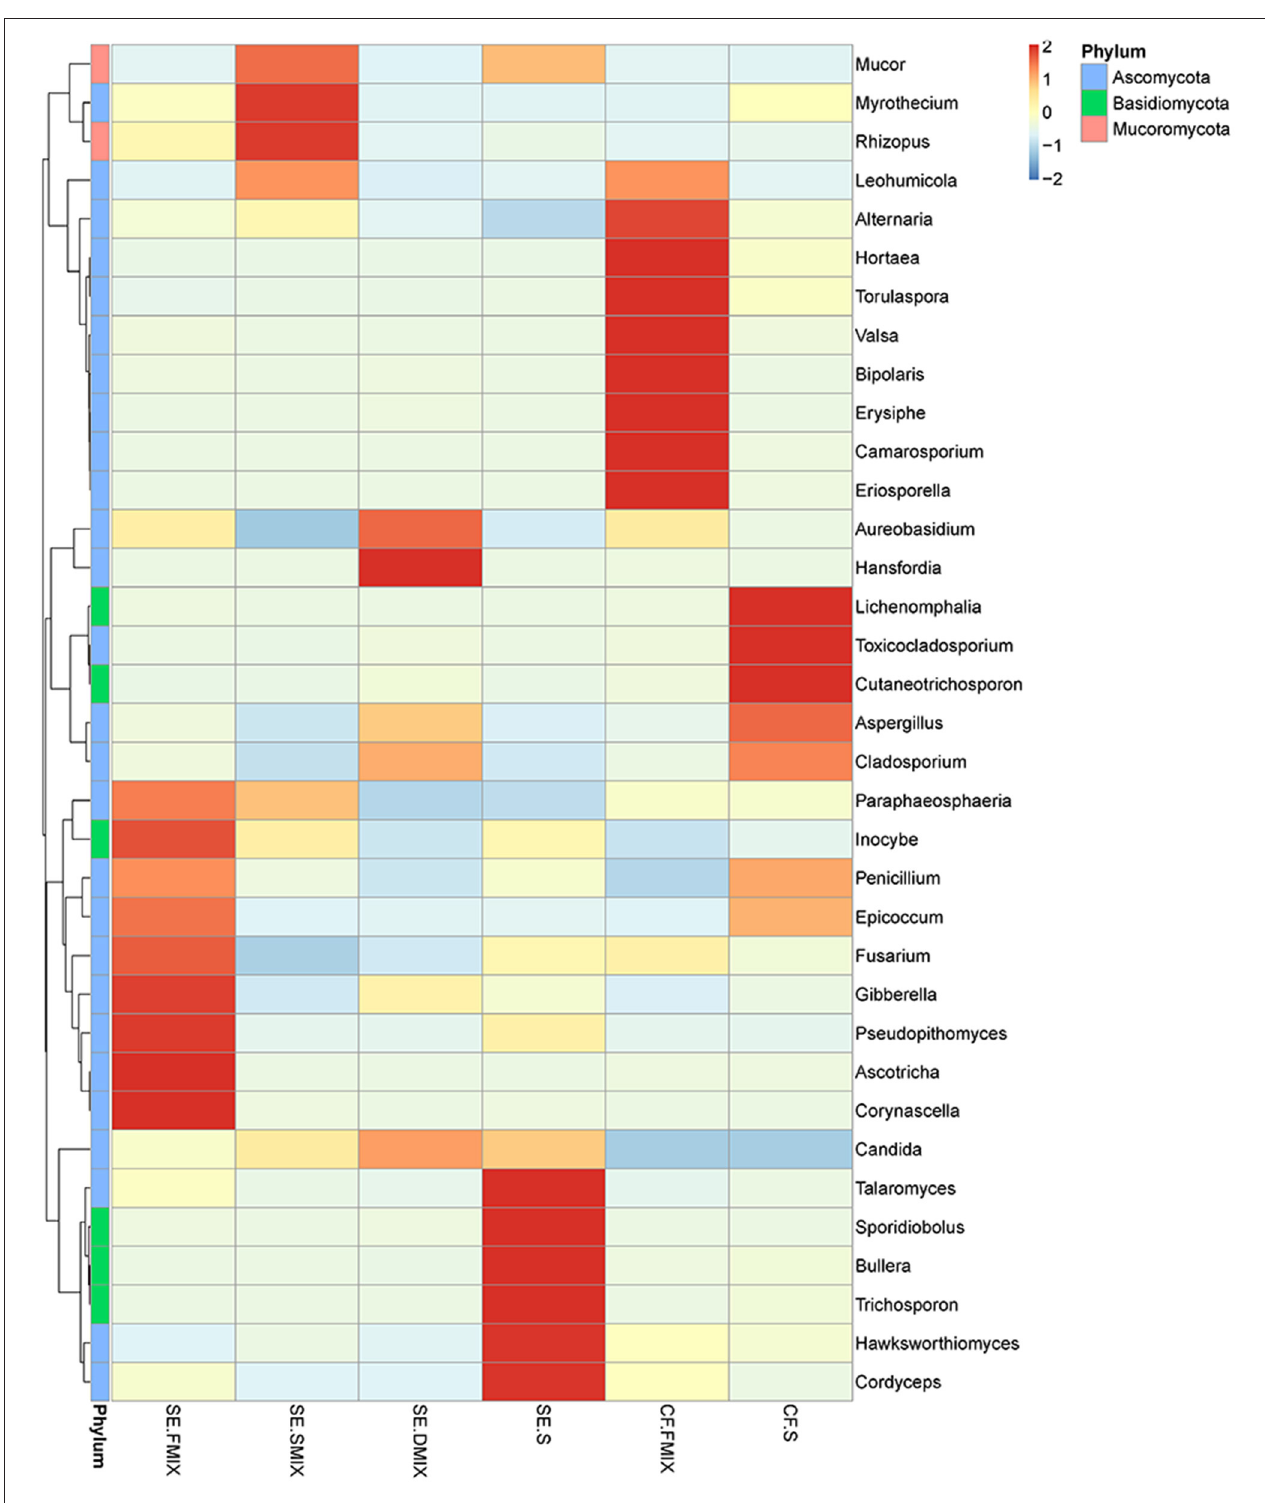
FIGURE 2 | Heat map of the 35 most abundant genera for each category. Sample information was in the vertical direction, annotation information was in the horizontal direction.